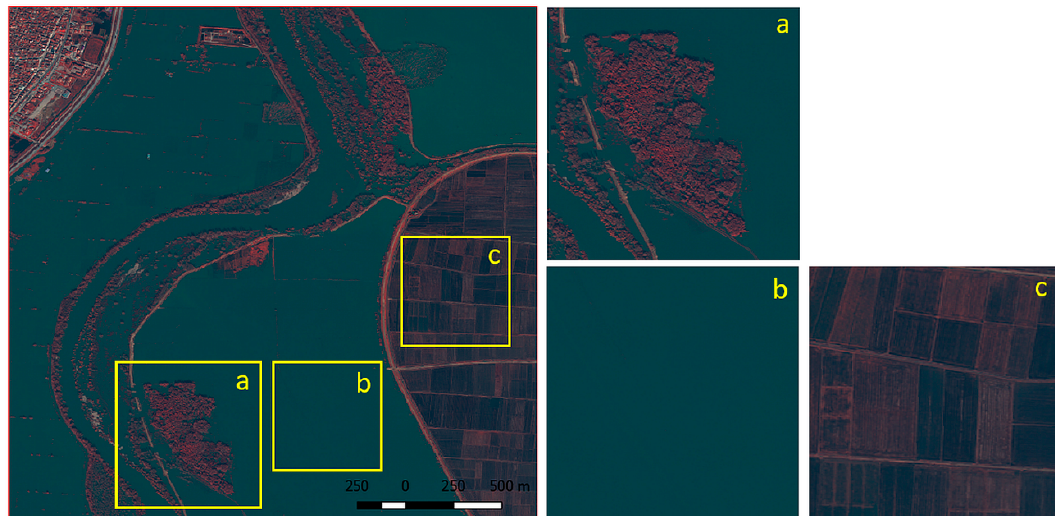
Figure 2. High-resolution false-color (NIR (near infrared), green, blue) WorldView2 image (March 11, 2015) (© European Space Imaging/DigitalGlobe) for northern Greece/Turkey containing temporary flooded vegetation (TFV) ( a ), temporary open water (TOW) ( b ), and dry land (DL) ( c ).